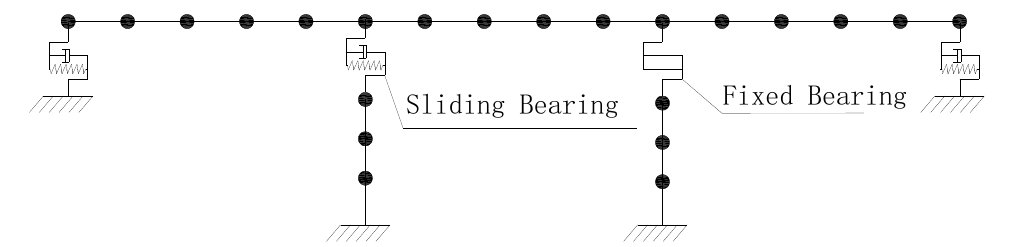
Figure 2. Diagram of continuous girder bridge finite element discrete model.